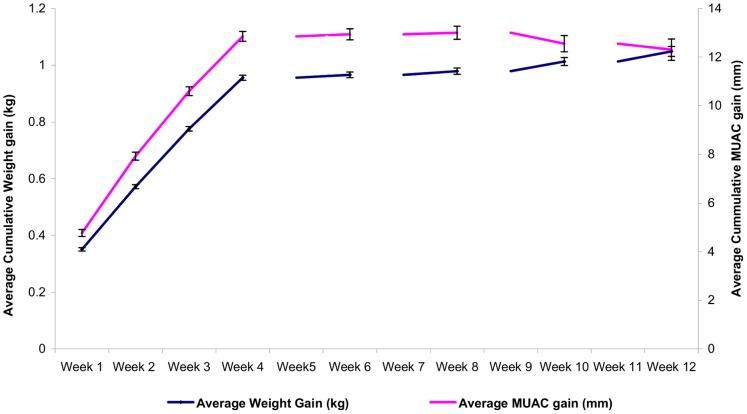
Average cumulative weight gain with average cumulative MUAC gain, MSF Therapeutic Feeding Program, Burkina Faso.Rate of average weekly MUAC gain mirrors average weekly weight gain for all 22,094 children who met discharge criteria for recovery.